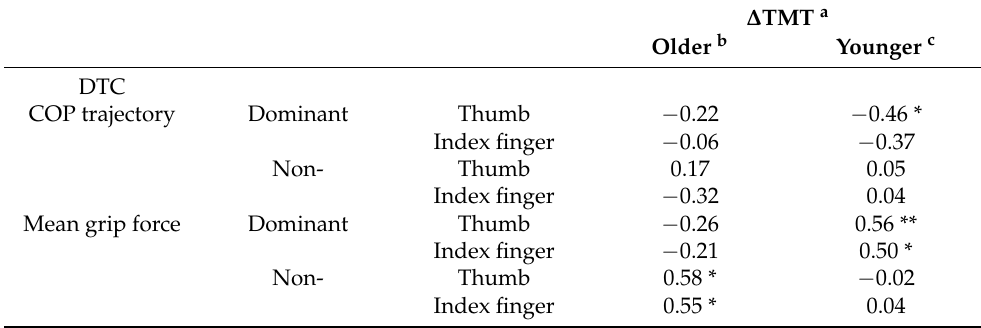
Table 4. Correlations between the DTC of kinetic parameters and ∆ TMT.